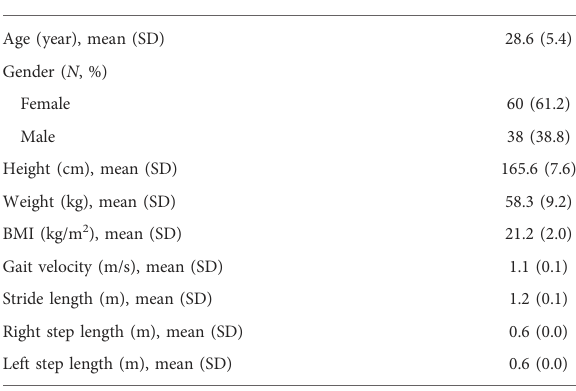
TABLE 1 Participants demographic data.